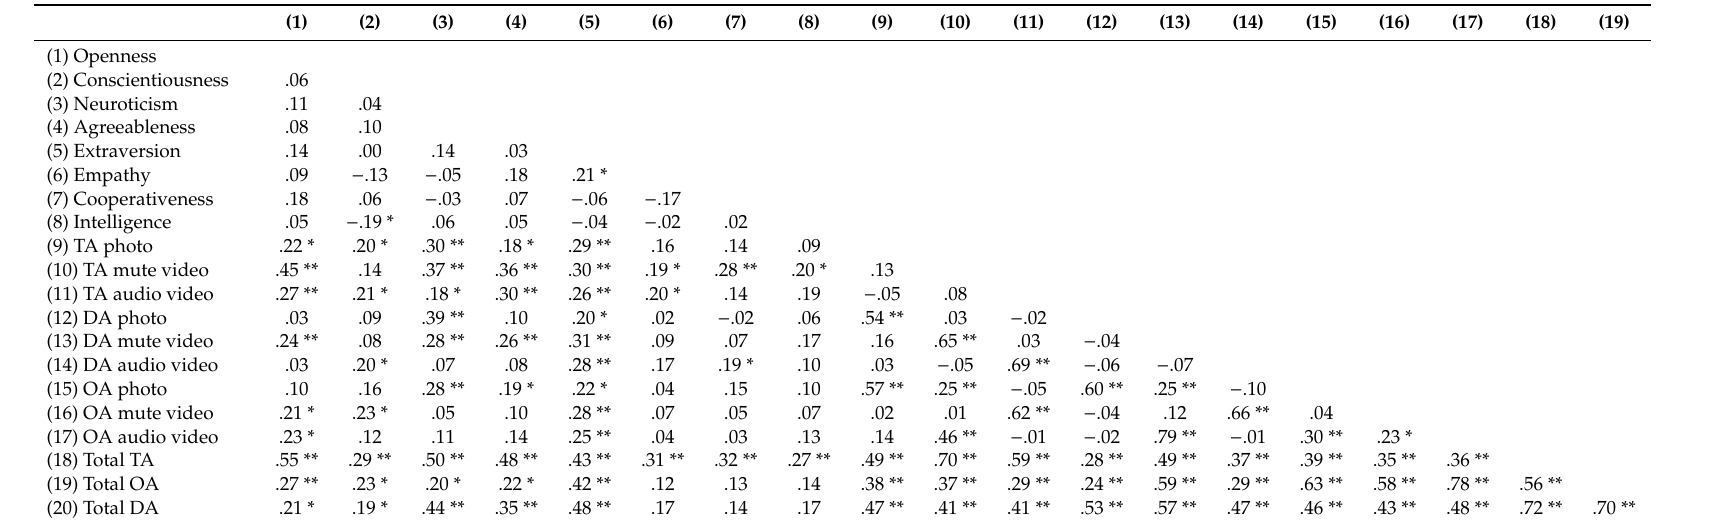
Table A2. Spearman Rank Correlations among All Accuracy Measures and